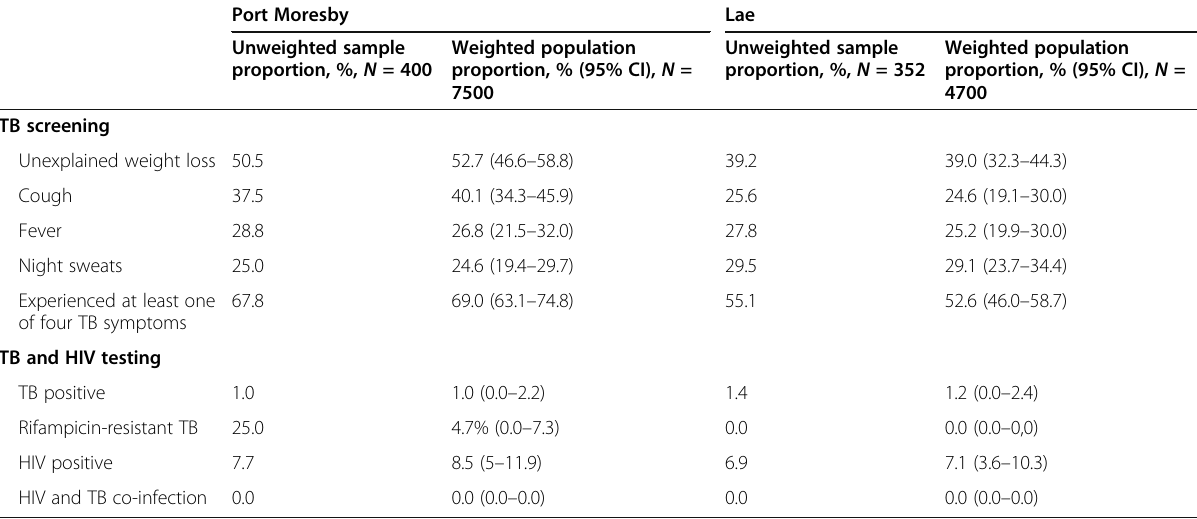
Table 1 MSM and TGW — TB screening and testing and TB and HIV co-infection Port Moresby